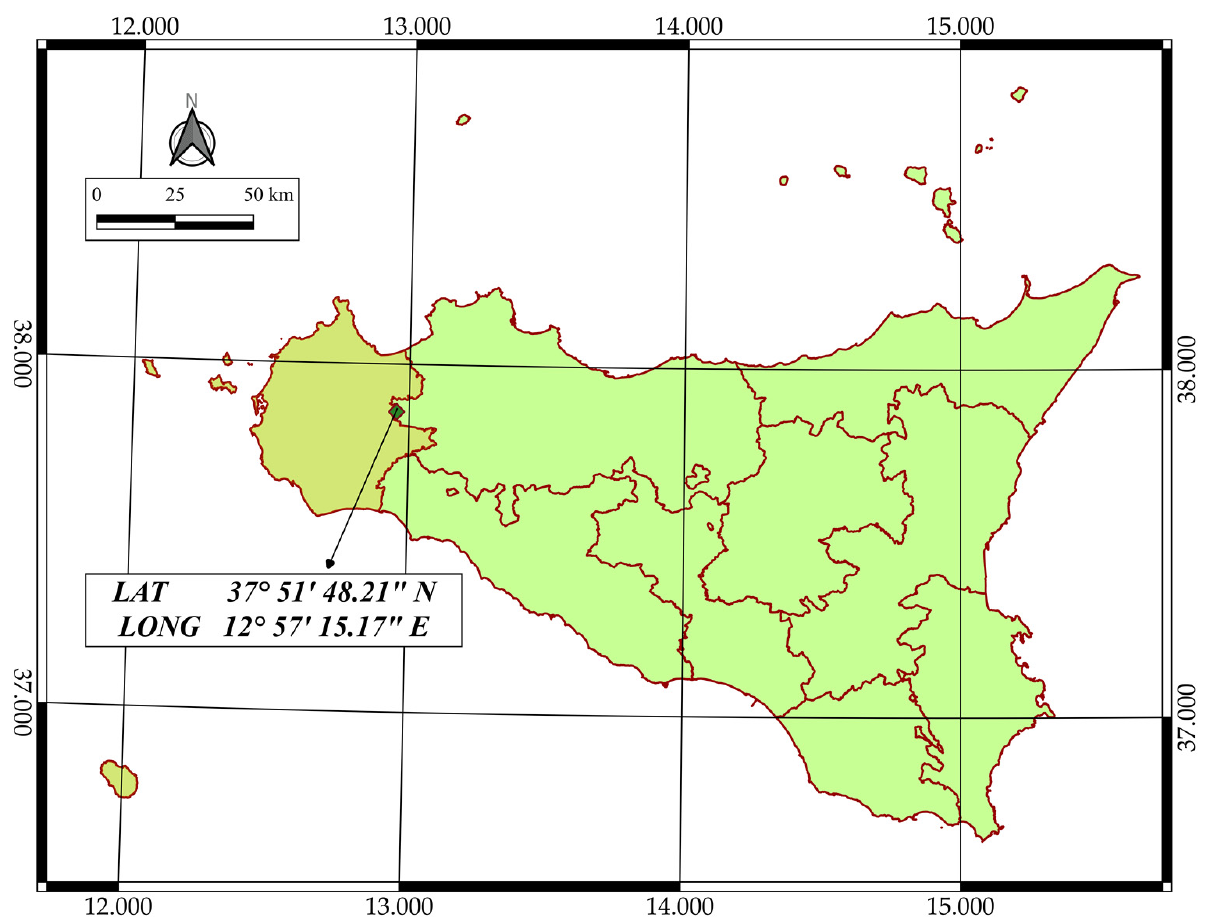
Figure 1. Geographical position of the study area in Sicily (Italy).